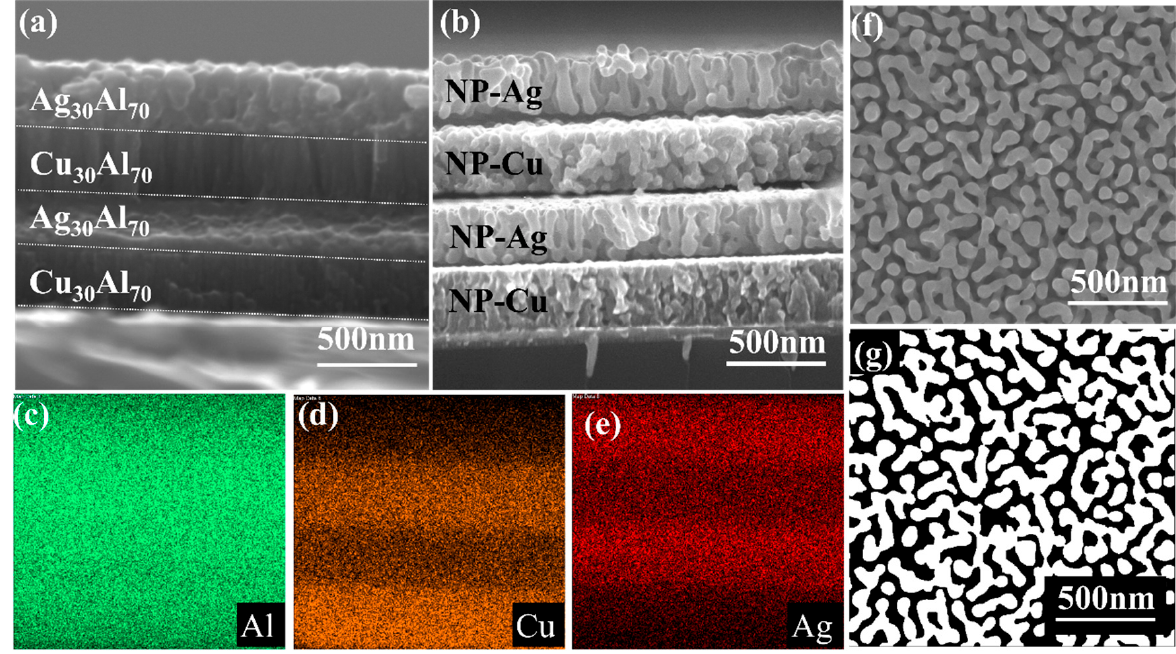
Figure 4. Cross-sectional SEM images of ( a ) the Cu/Ag precursor multilayer films and ( b ) as-dealloyed NP-Cu/Ag multi- layer films. EDS element distribution image of Cu/Ag precursor multilayer films: ( c ) Al, ( d ) Cu and ( e ) Ag. ( f ) Plan-view SEM image of NP-Cu/Ag multilayer films. ( g ) The bright and dark segmentation mask images generated from ( f ) by AQUAMI software.